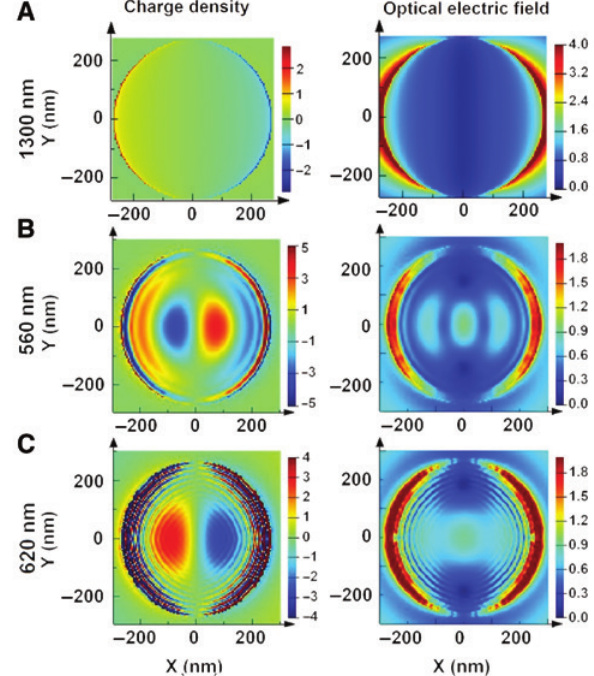
Figure 7: Theoretical analysis on different orders of the plasmons. (A–C) Calculated charge density (left) and optical electric field (right) distribution for the gold nanoparticles at 1300, 560, and 620 nm, respectively. Left: red and blue colors represent positive and negative charges, respectively, and the positive and negative numbers on the color bar represent the relative values of charge densities for the positive and negative charges, respectively. Right: red and blue colors represent the higher and lower intensities of the optical electric field, respectively, and the numbers on the color bar represent the relative intensity values of the optical electric